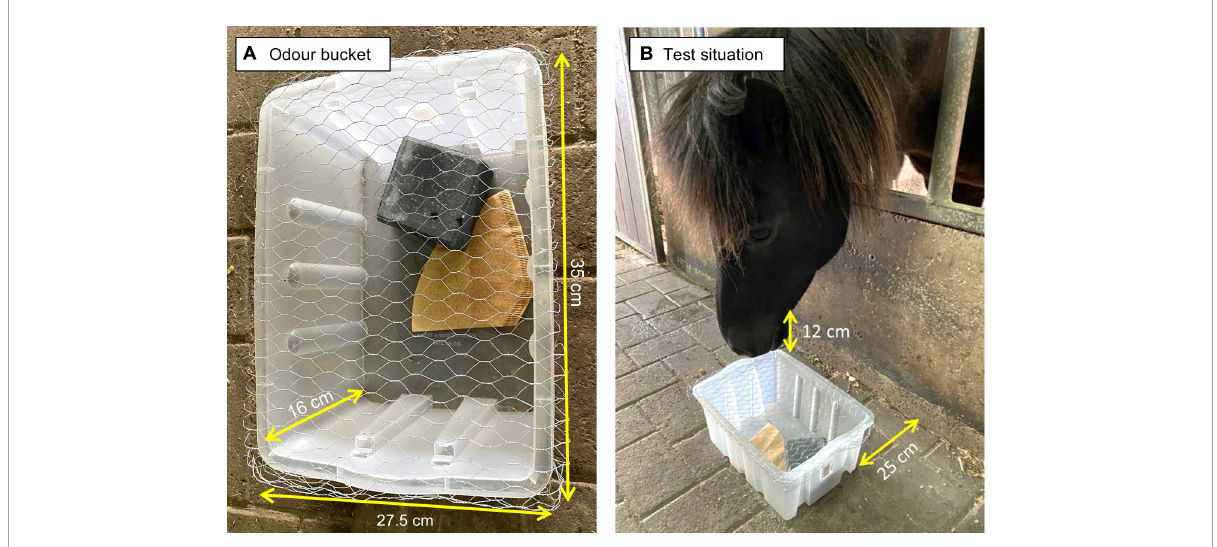
FIGURE1 (A) Illustration of an odor bucket with wire mesh lid, ballast rock and filter paper (with odor sample). The odor bucket measured 35 × 16 × 27.5 cm. (B) Illustration of the test situation. The odor bucket was placed on the aisle floor 25 cm from the grating to the horse’s pen. Sniffing duration was measured as from when the horse’s muzzle was within the length of one horse muzzle (12 cm) away from the